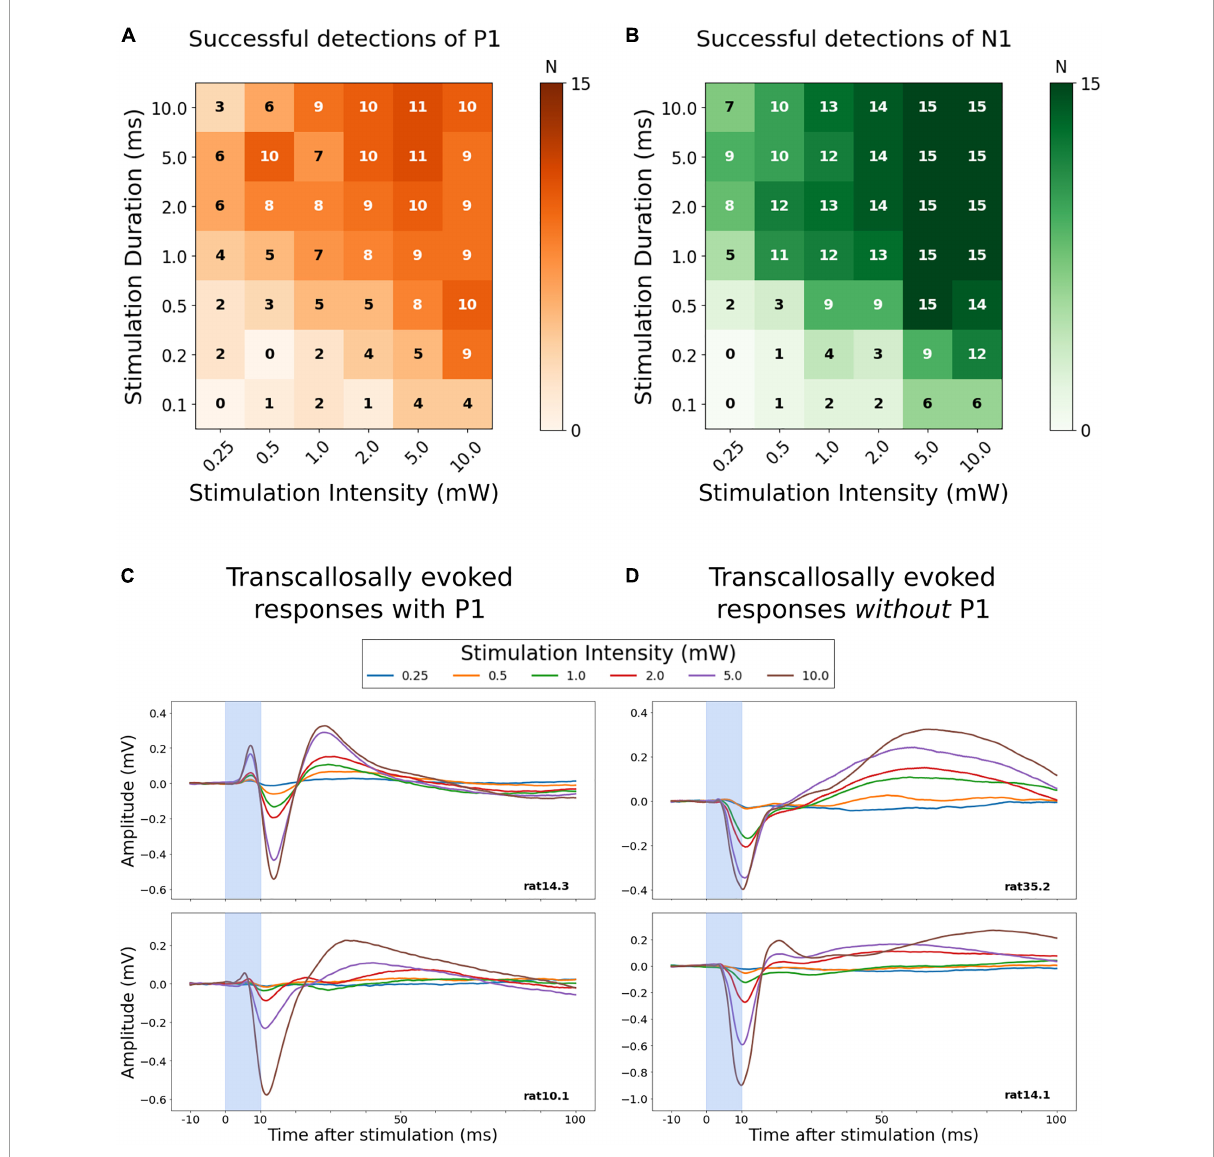
FIGURE3 Detectability of a transcallosal P1- or N1-peak response depending on stimulation intensity and duration. (A,B) The upper panels show color-coded grids indicating the relative frequency of successful P1 peak detection (orange) or N1 peak detection (green) in left M1 after optogenetic stimulation of right M1. Each grid cell corresponds to one of the 42 combinations of stimulation intensity (x-axis) and duration (y-axis). The numbers plotted inside each cell of the grid indicate the absolute number of animals showing a detectable peak. The lower panels depict averaged samples traces of the transcallosal LFP of four animals. Two animals show a P1-peak (C) , while a P1 peak is absent in the other two animals (D) . Stimulation duration was fixed (10 ms). Stimulation intensities are indicated by color